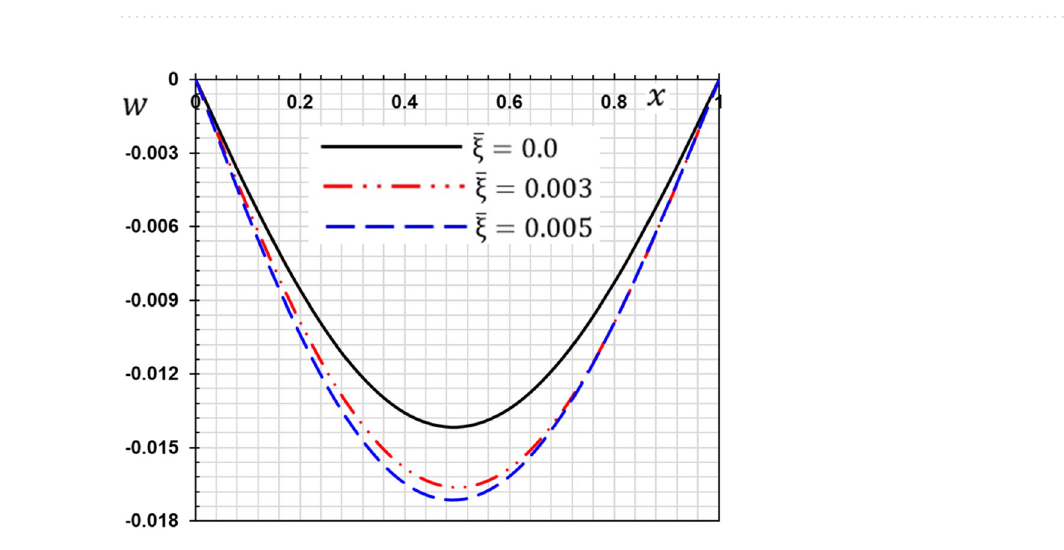
Table 2. Comparison of the values of temperature θ and deflection w with Ref. 15 .